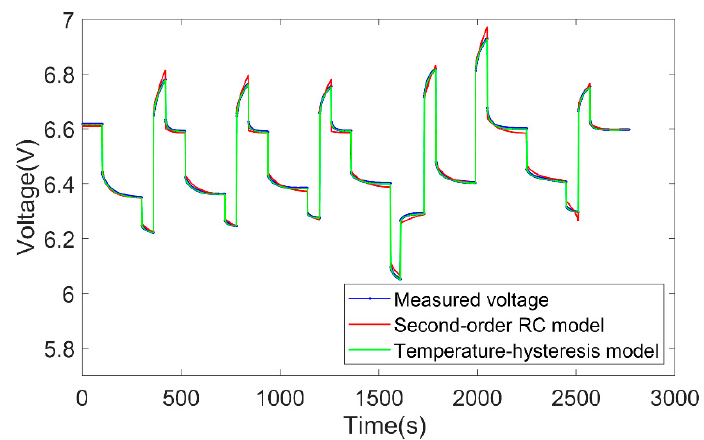
Energies 2019 , 12, x FOR PEER REVIEW 17 of 25 Figure 16. Battery models output and measured voltage under variable temperature conditions.